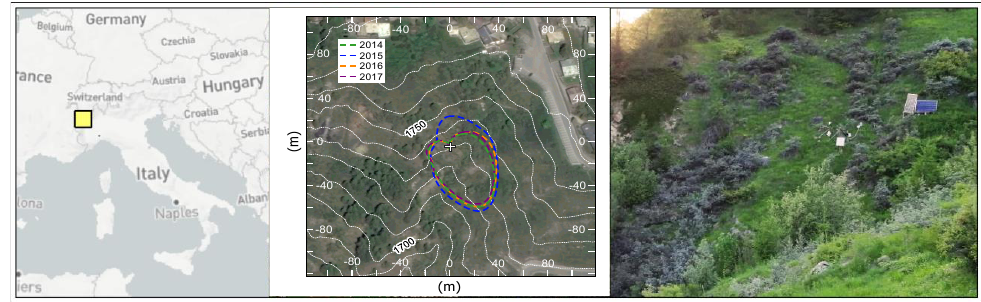
Figure 1. The Cogne experimental site with the flux footprint labelled in the second panel with a satellite image of the site area (Google Earth, © Google 2021). The contour lines of the flux footprint enclose the area which contributes 80% of the total